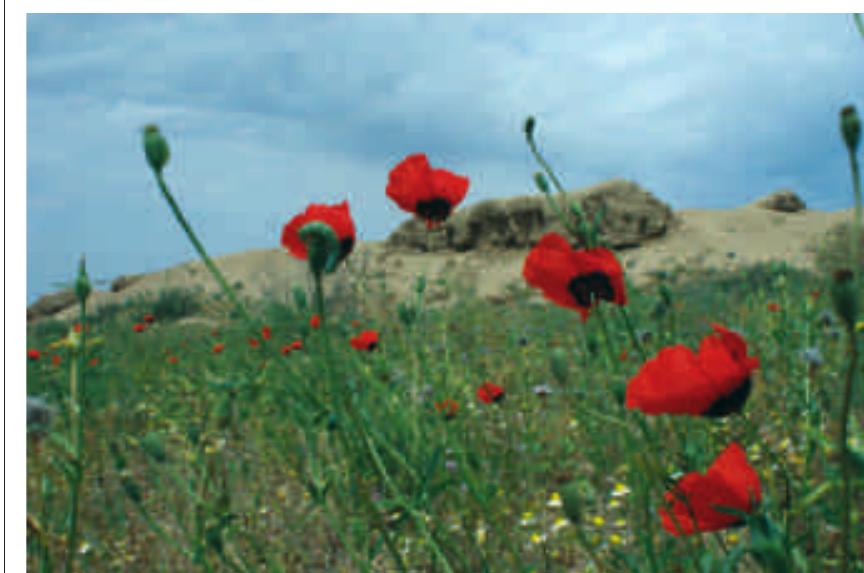
Figure 3 The remains of a double-courtyard caravanserai (KRS01) recorded during the desert survey. The spring rains have just brought out a wonderful carpet of wild flowers, which are resplendent for about 2–3